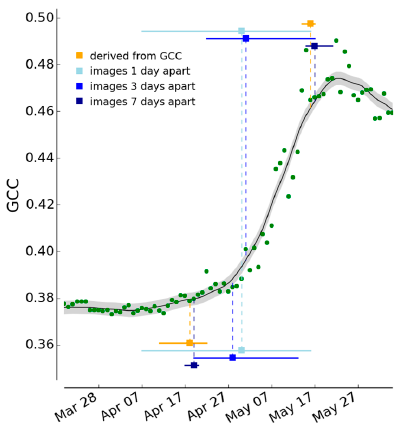
Figure 10. Estimates of start and end of spring from Season Spotter based on image pairs one (light blue), three (medium blue), and seven (dark blue) days apart, as well as estimates derived from G CC values (orange). Green circles indicate daily G CC values, the black line is the fit curve to the G CC values, and the gray region represents the uncertainty in the curve. Blue and orange squares indicate date estimates. Horizontal lines through them are 95% certainty ranges. Shown is the site harvard for 2012. Curves for other site-years can be found in Supplementary Figure S5.